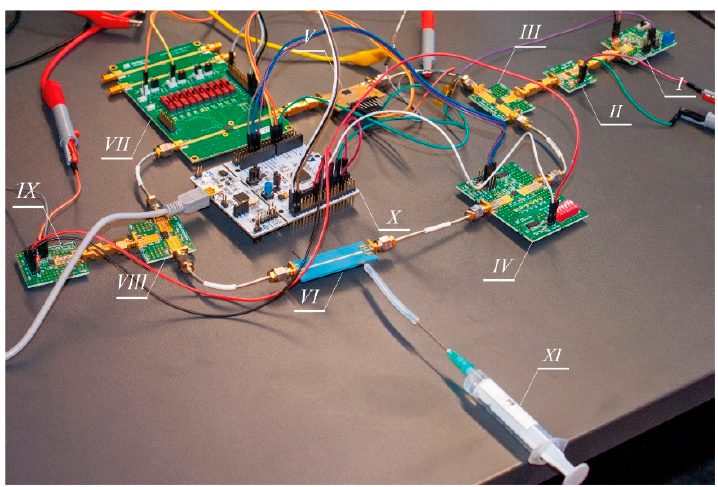
Figure 6. Photography of the test bench used to validate the described microwave microfluidic system for measurements of liquid solution concentrations.